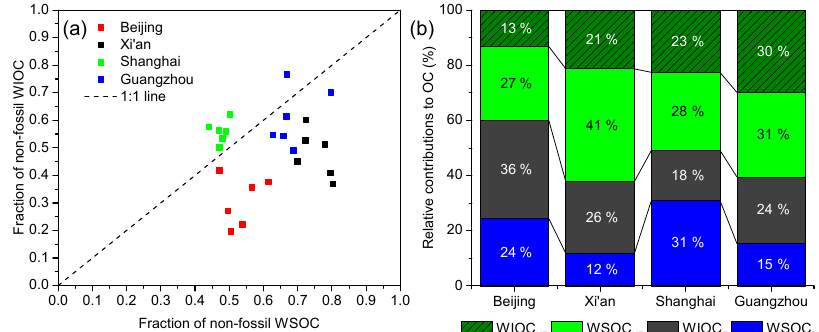
Figure 6. Relationship between the fraction of non-fossil WIOC and WSOC (a) and averaged relative contribution (%) to OC from WSOC and WIOC from non-fossil and fossil sources (b)